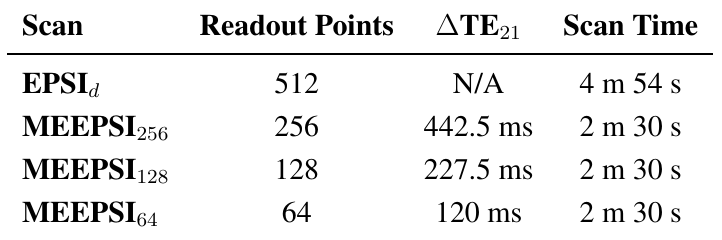
Table 2. Varying in vivo scan parameters. Fixed parameters were: TE